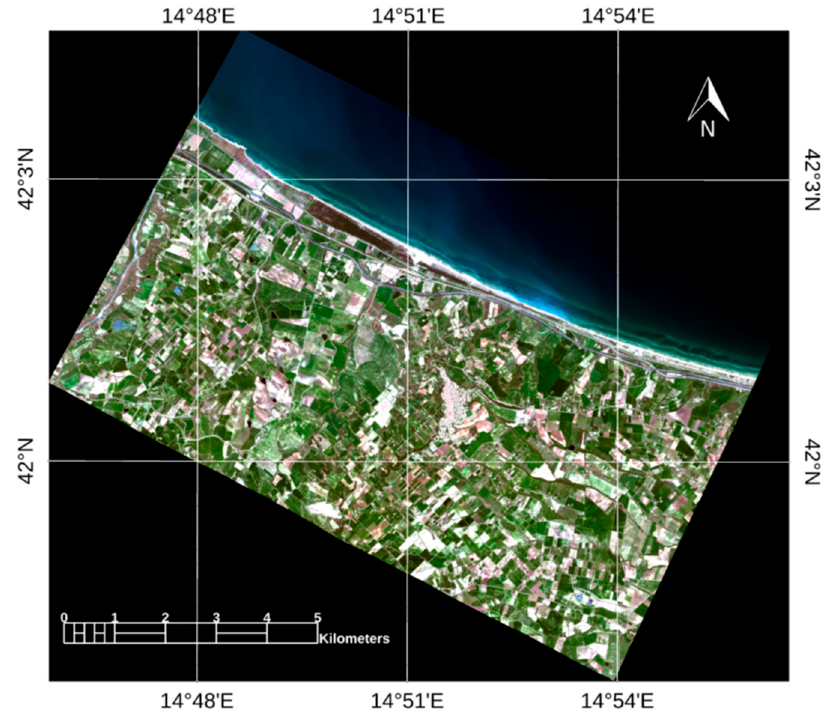
Figure 3. Corrected to reflectance WV2 imagery clipped to the TASI flyover area. RGB (R: 659 nm; G: 546 nm; B: 478 nm) imagery.